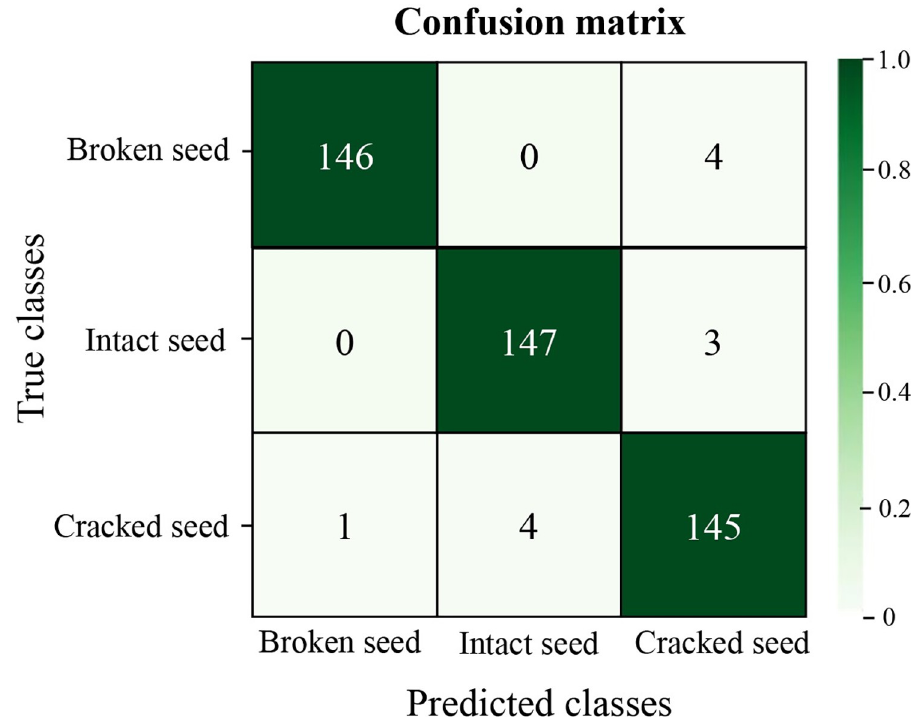
Fig 11. Confusion matrix for the Impro-ResNet50